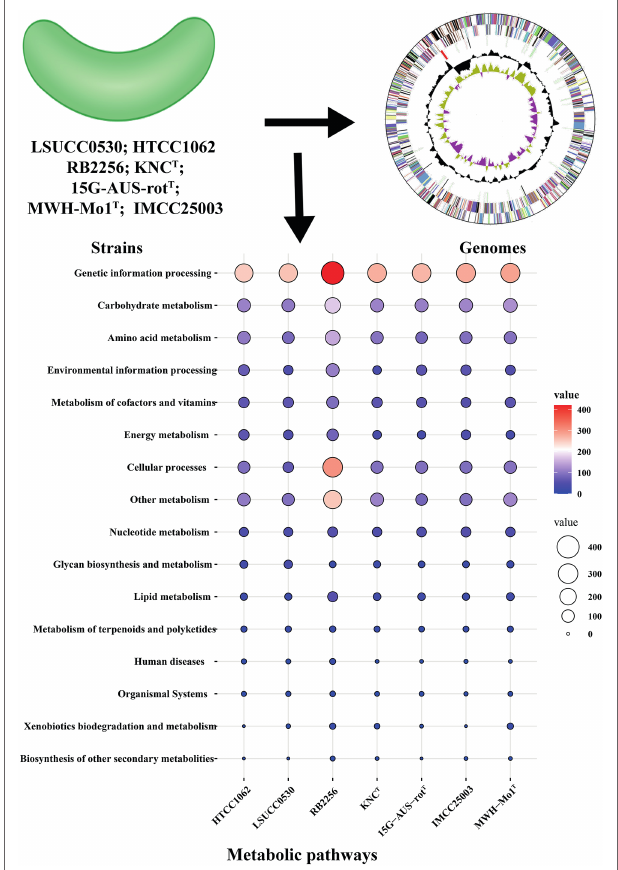
FIGURE 2 | Analysis of the potential metabolic functions of LNA bacteria and ultramicrobacteria. The protein sequences of bacteria were obtained from NCBI database and annotated in KEGG database. The value in the diagram represents the number of proteins involved in the pathways.